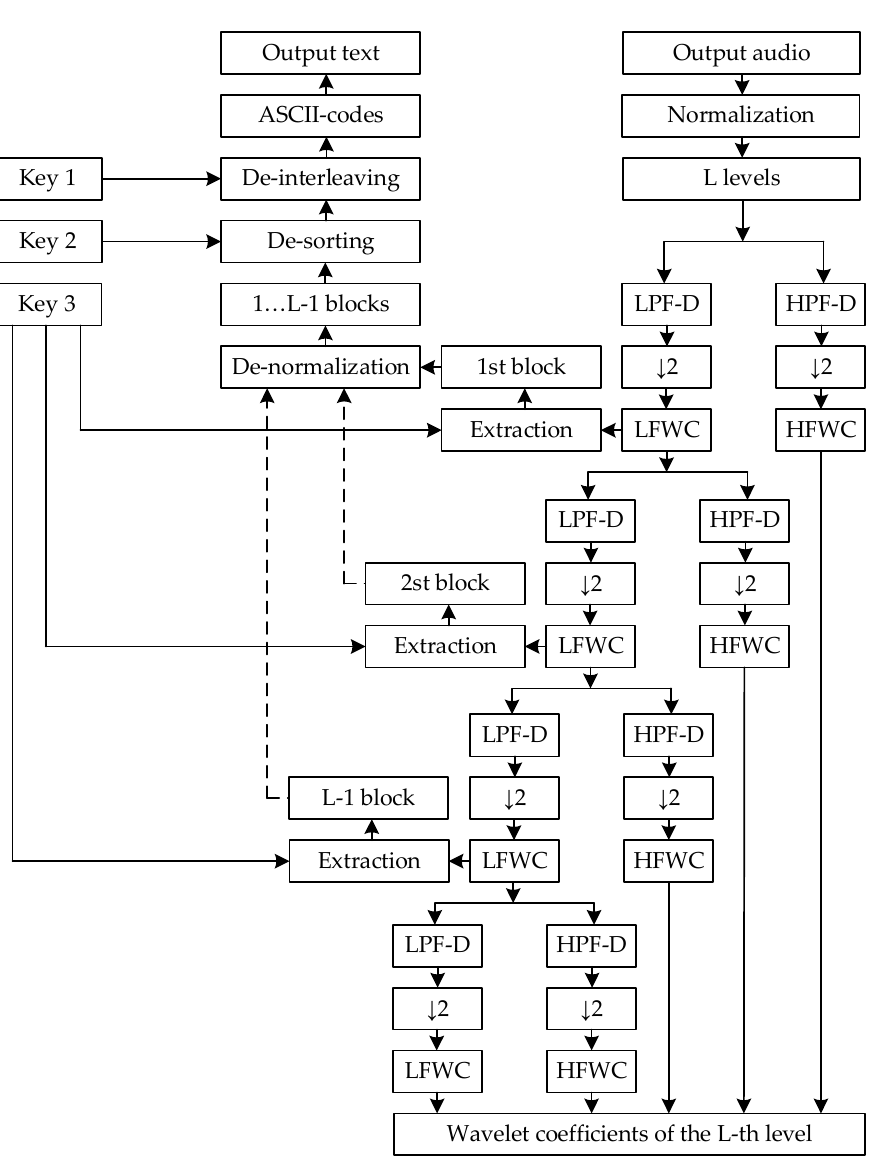
Figure 2. Structural diagram of the proposed method for extracting text information from an audio signal.